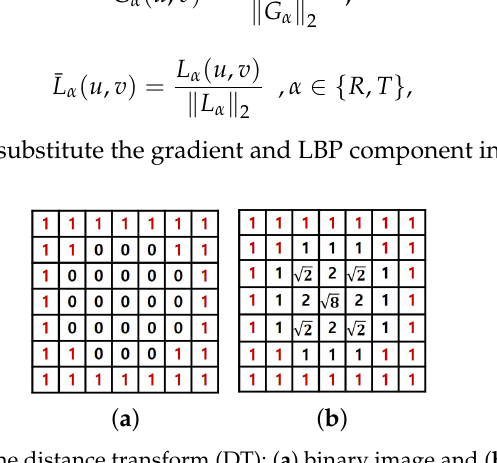
Figure 8. Process of the distance transform (DT): ( a ) binary image and ( b ) the result of DT.